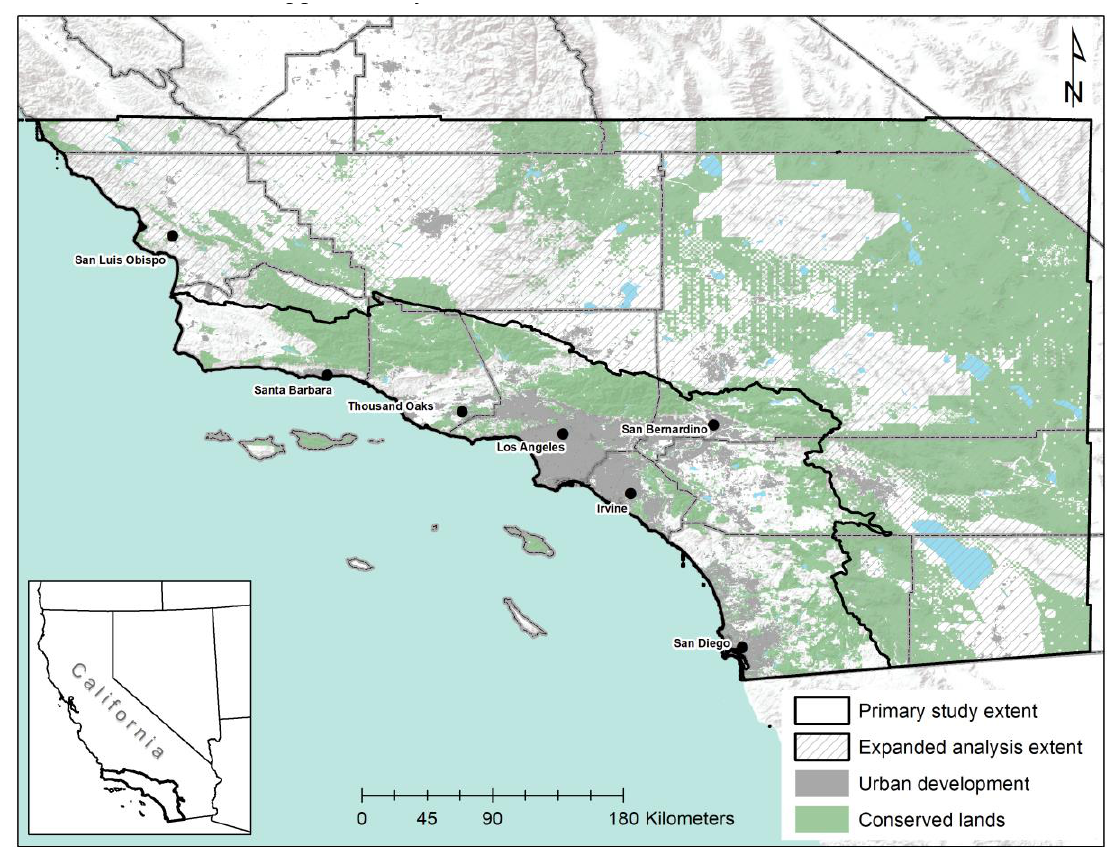
Figure 1. Map depicting the primary study area within southern California, U.S.A., with conserved lands identified in green and urban development in gray. The hatched area represents the expanded analytical extent.